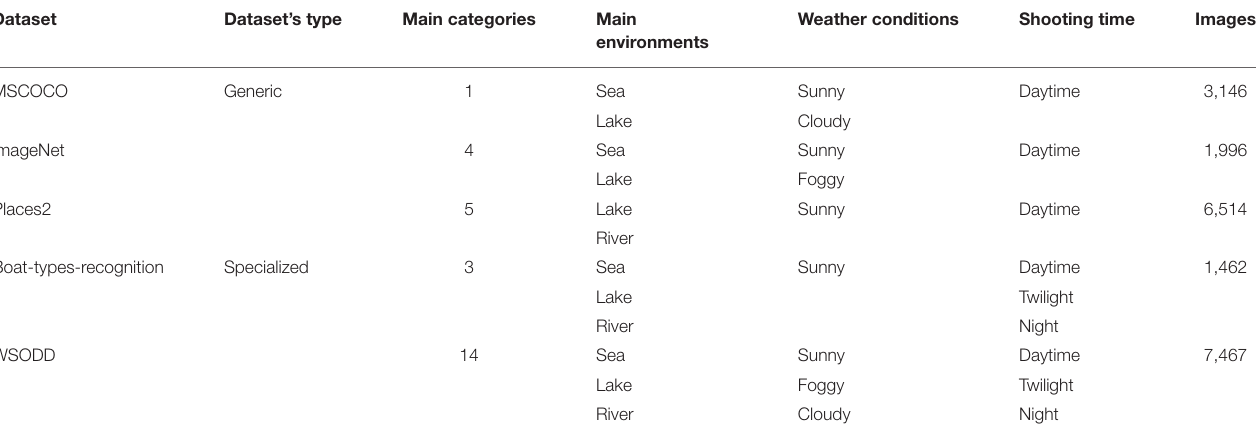
TABLE 1 | Comparison of WSODD and other image-based water surface object detection